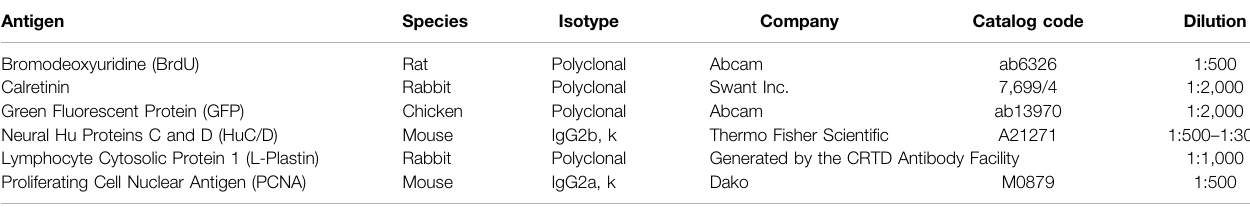
TABLE 1 | Primary antibodies used for immunohistochemistry on sections.